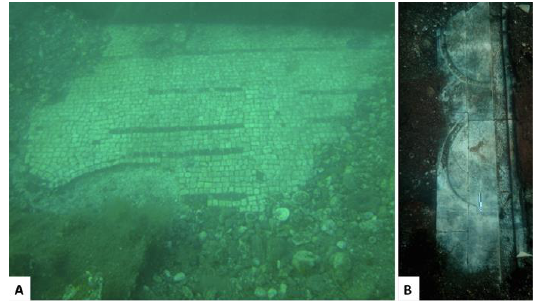
Fig. 3 – Villa con ingresso a protiro. A, a detail of black and white mosaic floor. B, threshold of a sliding